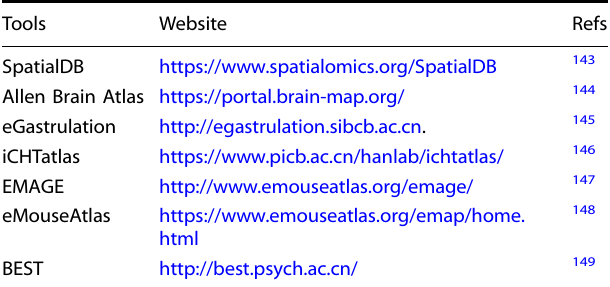
Table 3. Representative ST online